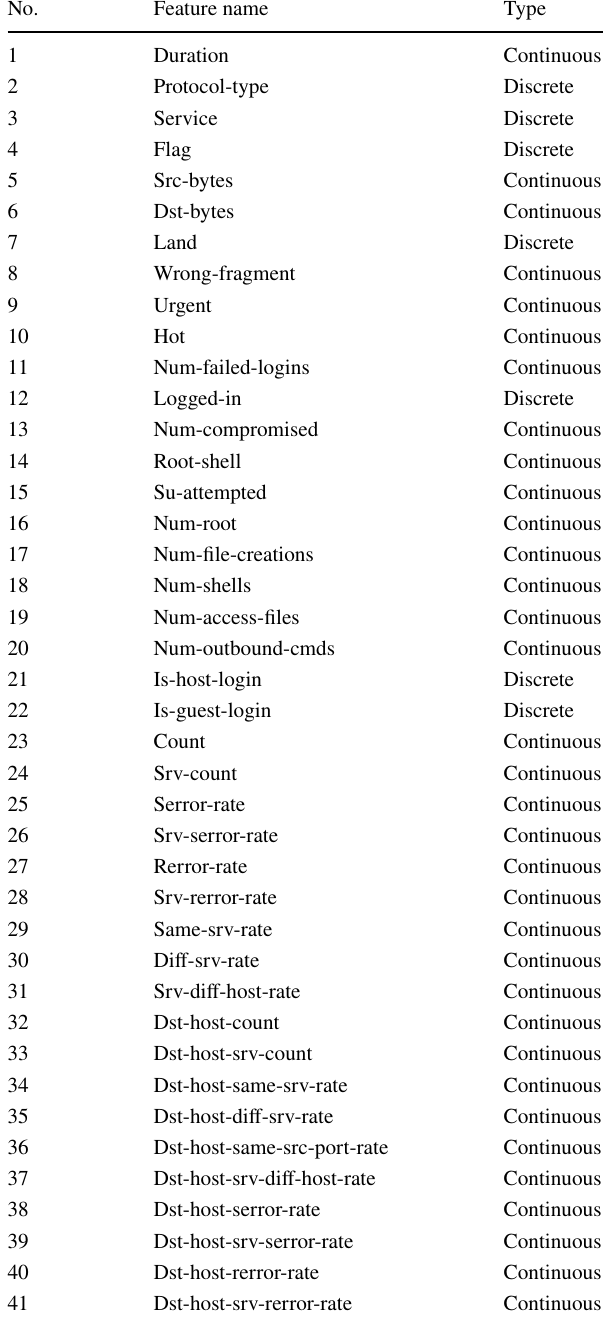
Table 1 List of features in the NSL-KDD dataset